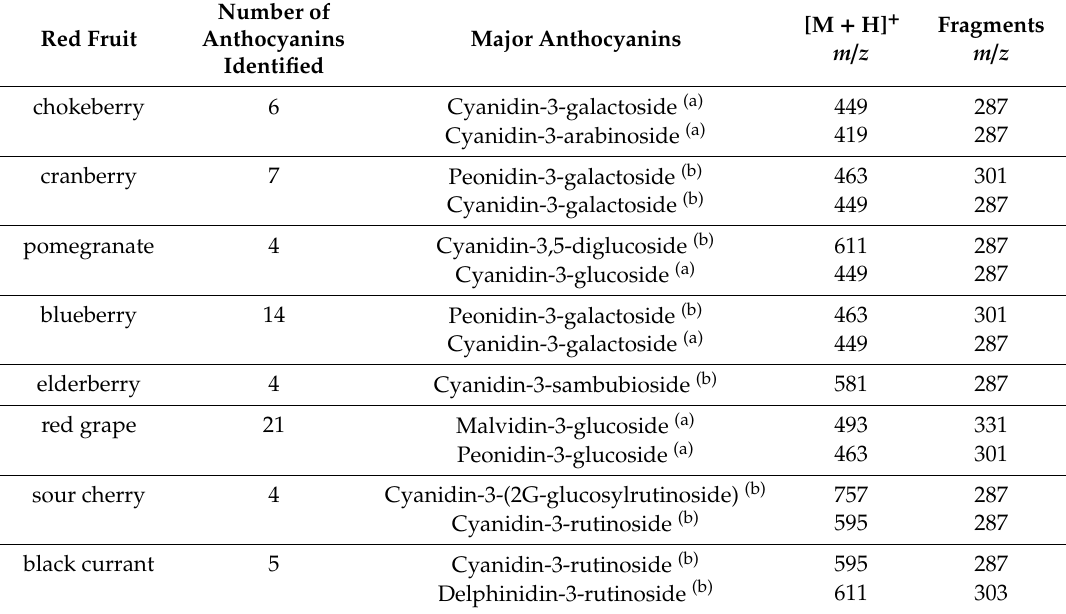
Table 1. Major anthocyanins in the extracts of chokeberry, cranberry, pomegranate, blueberry, elderberry, red grape, sour cherry, and black currant identified in this study using (a) HPLC-ESI-MS n analysis and authentic references or (b) tentatively identified using HPLC-ESI-MS n analysis and literature data. For details, see the Materials and Methods section, Section 4.3.